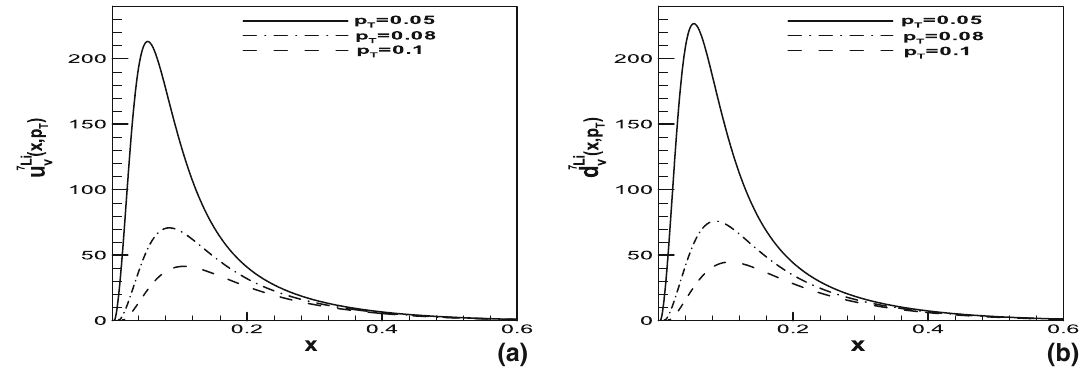
Fig. 2 The TMD valence quark distributions of 7 Li nucleus: a u v ( x , p T ) , b d v ( x , p T ) with respect to x at p T = 0 . 05 GeV , 0 . 08 GeV and 0 . 1 GeV